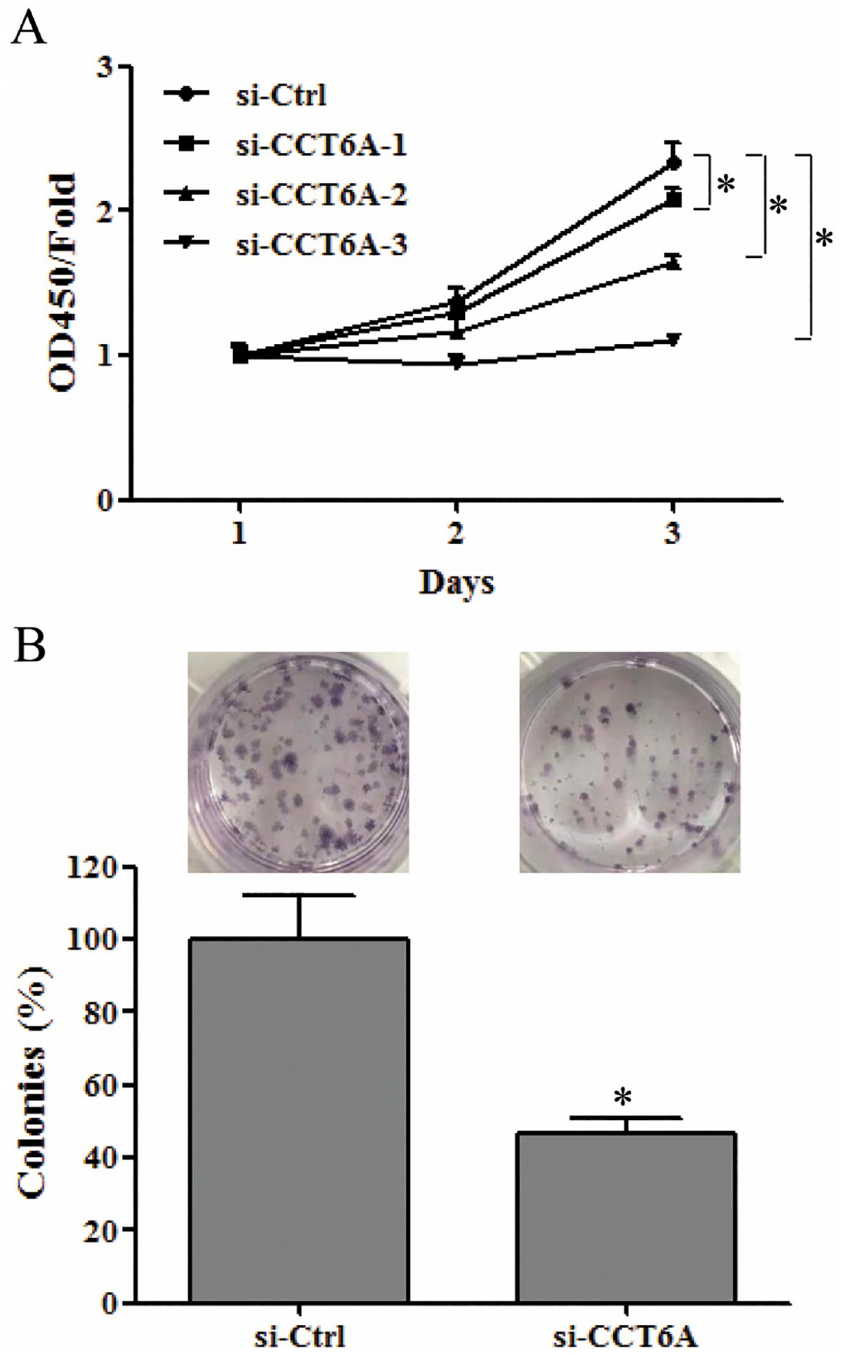
Fig 3. The effect of CCT6A on U-2 osteosarcoma cell colony formation. (A). CCK-8 was used to detect the cell viability of U-2 OS cells transfected with three different si-CCT6A oligonucleotides or si-Ctrl for 24 h, 48 h, or 72 h. Data were normalized to viability on day 1 and shown as fold changes. (B) Cell survival was determined by colony formation analysis of the U-2 OS cells transfected with si-CCT6A-3 for 72 h and the si-Ctrl. The images shown represent three independent experiments and the quantification of our colony formation analysis. Data were normalized to the survival of the control cells and are shown as the mean ( ± SD) (error bars) from three independent experiments. � p < 0.05 vs. si-Ctrl. CCK-8, cell-counting kit-8; CCT6A, chaperonin-containing TCP1 subunit 6A; OS, osteosarcoma; SD, standard deviation; siCT6A-3, CCT6A siRNA; si-Ctrl, control siRNA; siRNA, small interfering ribonucleic